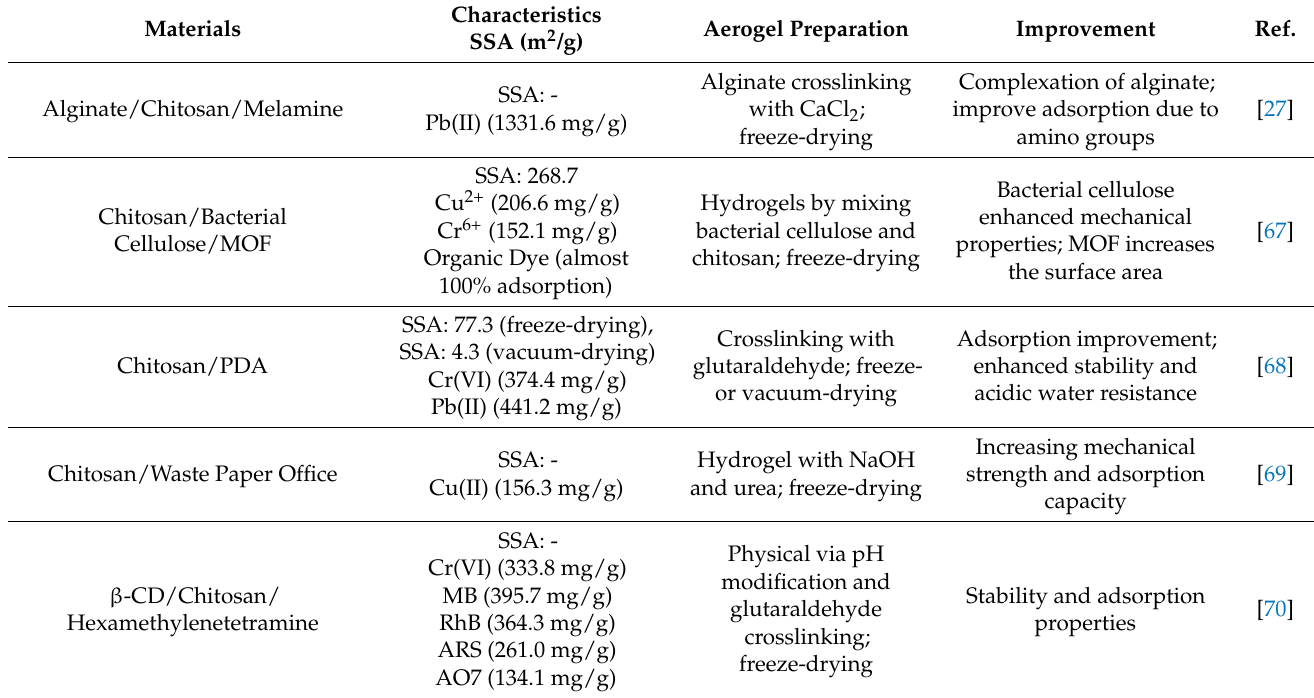
Table 2. Application of chitosan-based aerogels. β -CD: β -cyclodextrin; AO7: acid orange 7; ARS: alizarin red S; CMC: carboxymethyl cellulose; CMCh: carboxymethyl chitosan; CR: Congo red; CV: crystal violet; GO: graphene oxide; MB: methylene blue; MO: methyl orange; MOF: metal-organic framework; PDA: polydopamine; PDMS: polydimethylsiloxane; PVA: polyvinyl alcohol; RhB: rhodamine B; SSA: specific surface